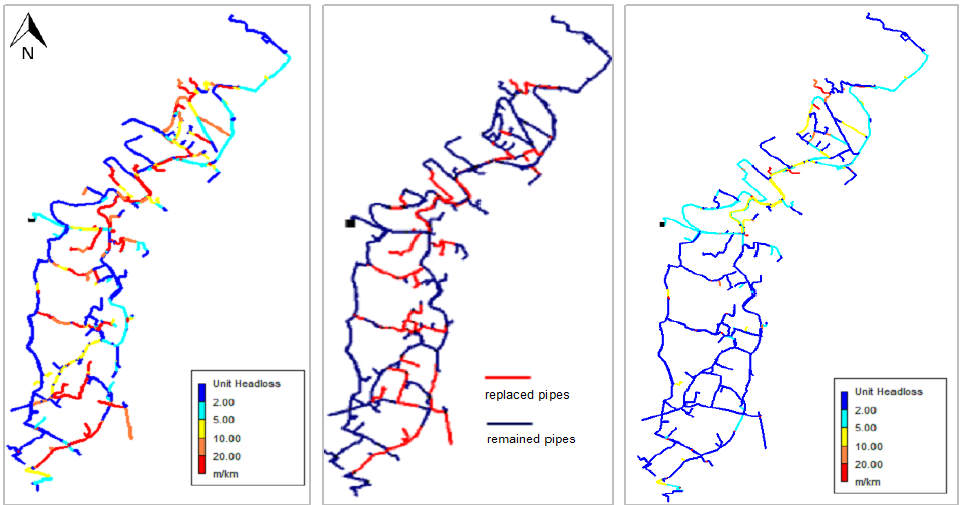
Figure 9. Unit head losses in the peak scenario in the status quo situation ( left ); identification of critical pipes for intervention ( center ); and unit head losses in the peak scenario in the proposed solution ( right ).